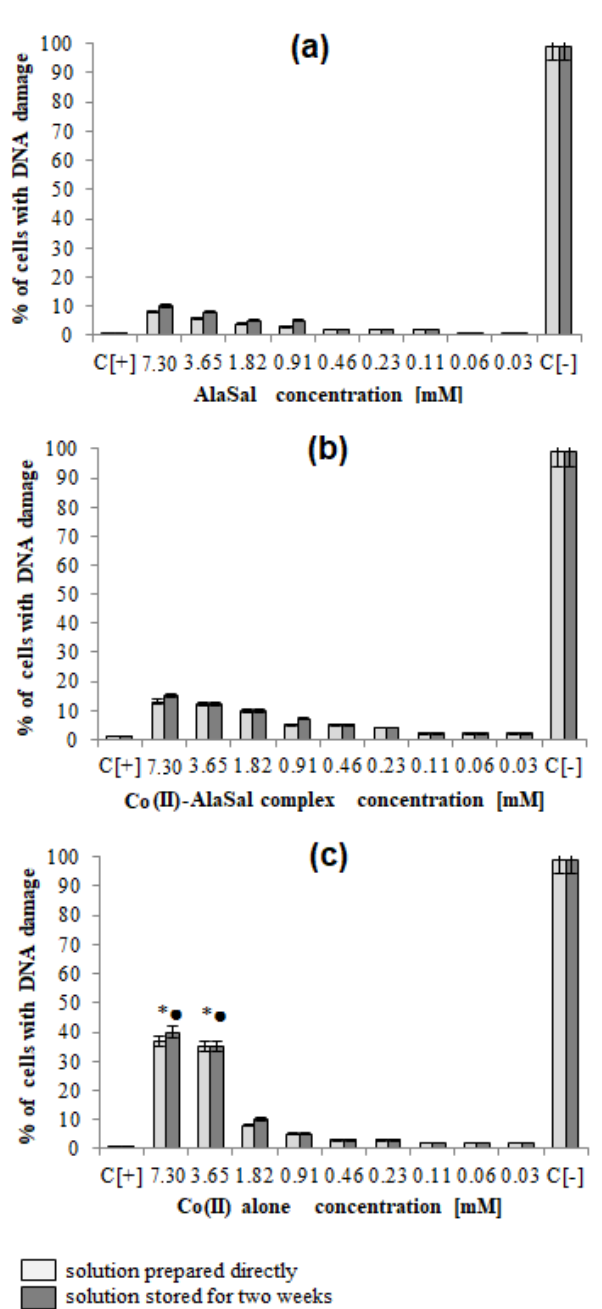
Figure 6. The percentage of L929 cells with damaged cell nuclei. The cells were stimulated for 24 h with: ( a ) AlaSal, ( b ) Co(II)–AlaSal complexes or ( c ) Co(II) alone and then stained by 4′,6-diamidino-2-phenylindole (DAPI). Statistical significance: *• p < 0.05; *untreated cells vs. cells treated with tested solution (solution prepared directly); • untreated cells vs. cells treated with tested solution (solution stored for two weeks).